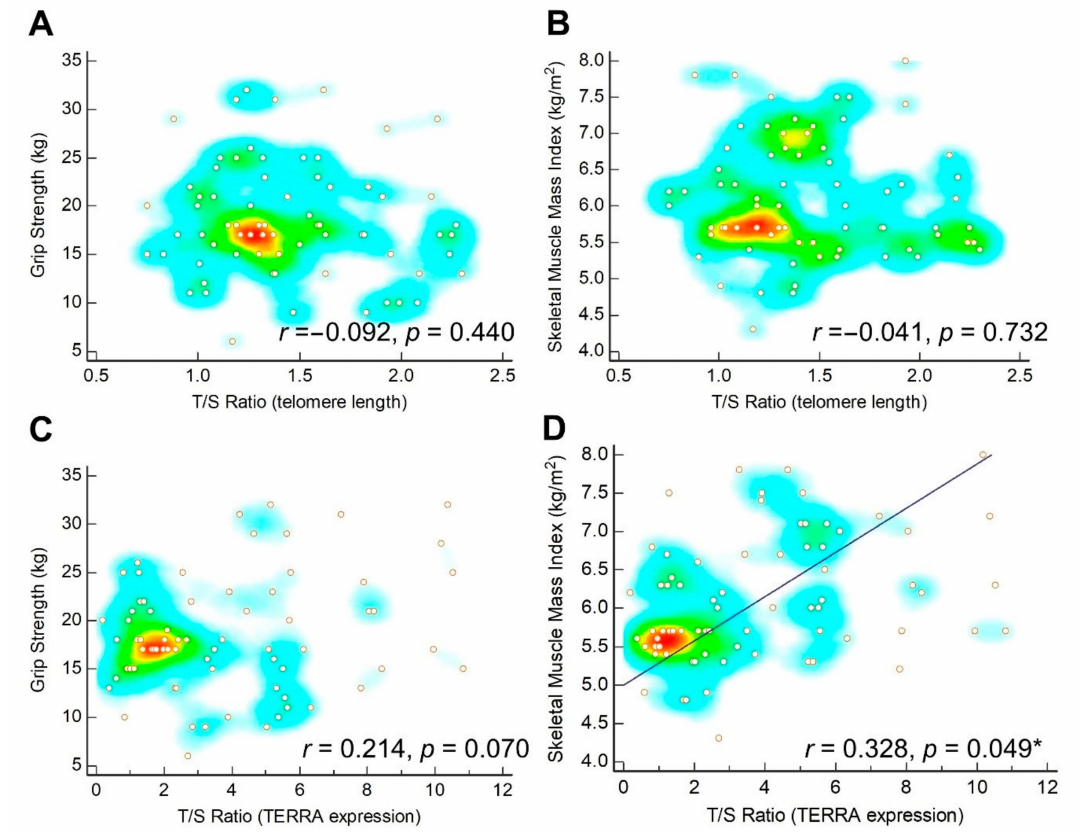
Figure 2. Scatter plots for correlation ( A ) between telomere length and grip strength, ( B ) between telomere length and skeletal muscle mass index, ( C ) between expression of telometric repeat–containing RNA (TERRA) and grip strength, and ( D ) between TERRA expression and skeletal muscle mass index. The regression line is plotted when p < 0.05. The heat map with background color coding suggests clusters of observations. * denotes p <